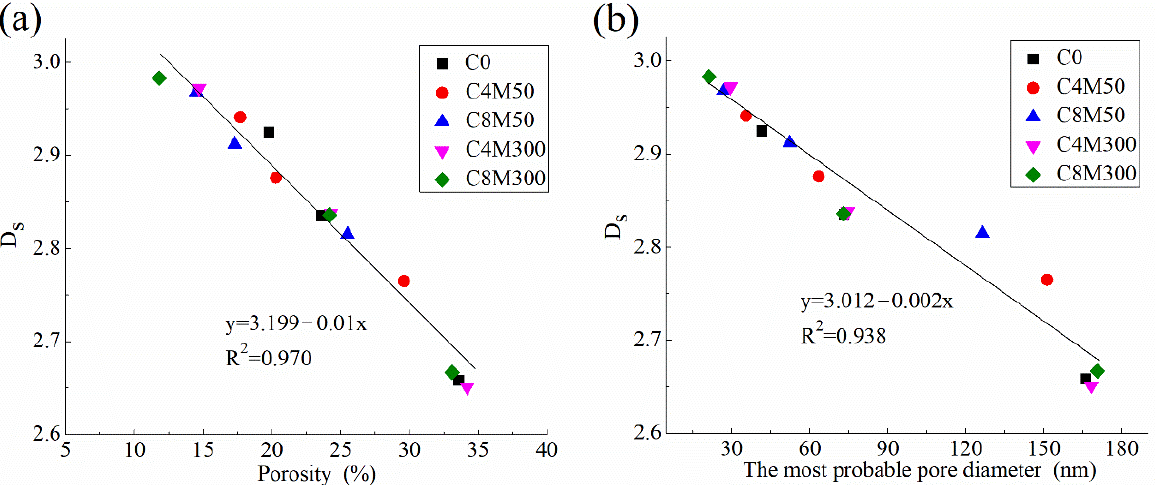
Figure 4. The correlation between D s and ( a ) porosity and ( b ) the most-probable pore diameter of concrete.